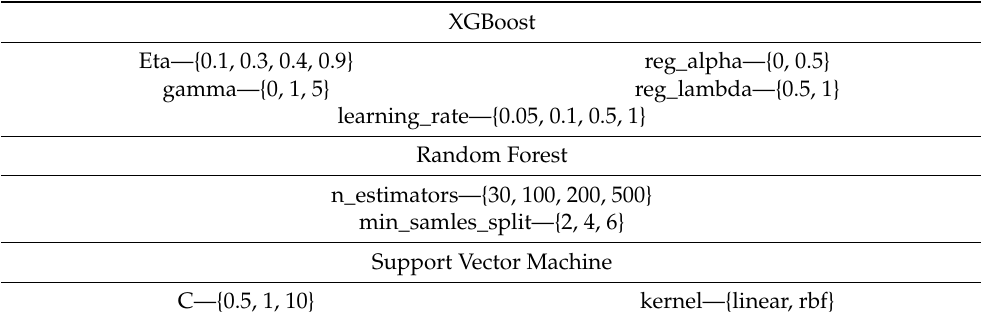
Table 3. Table of optimization hyperparameters with a grid search approach. Naïve Bayes had no hyperparameters to